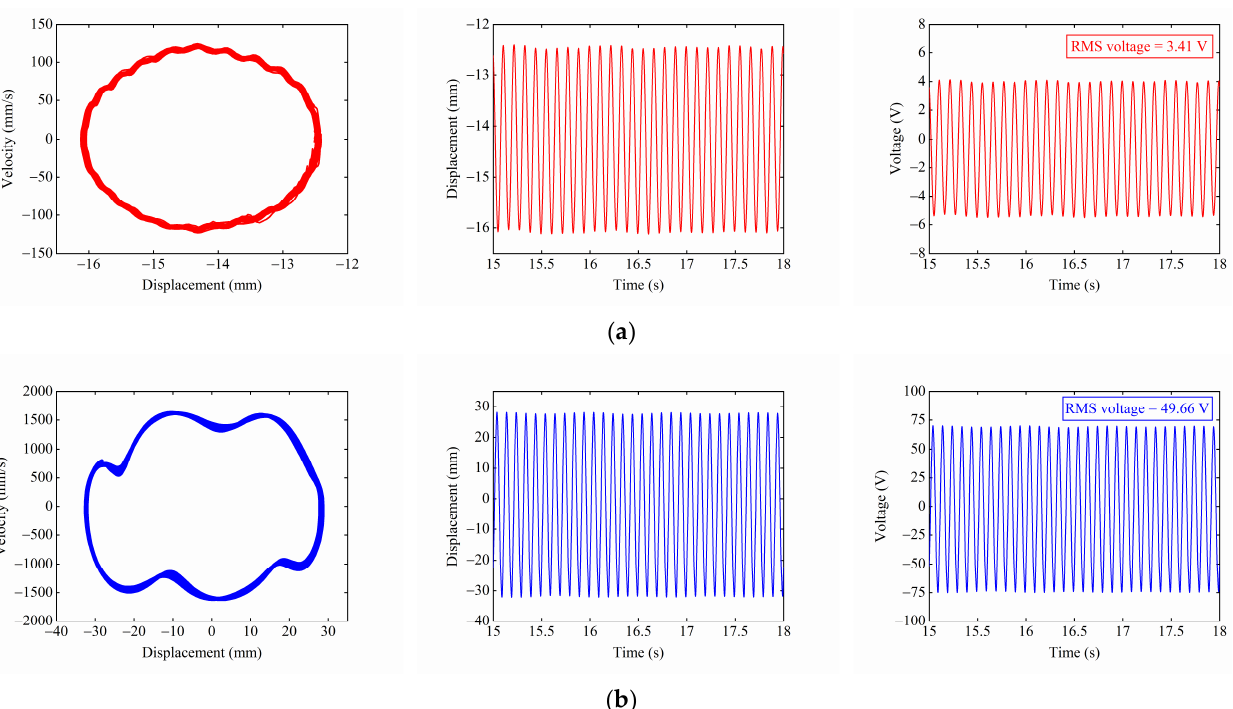
Figure 15. Phase graph, time course graph of the experiment under different u 0 : ( a ) u 0 = − 14 mm; ( b ) u 0 = 12